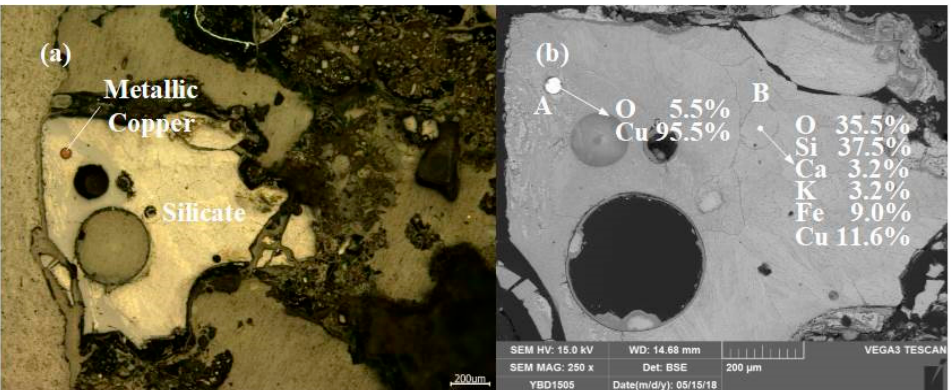
Figure 22. Optical micrograph ( a ) and SEM backsca tt ered electron image ( b ) of YBD16. Sample YBD17: Under the metallographic microscope, copper particles could be de- tected. EDS characterization showed that the copper particles contain 1.8% O, and Cu 2 O solid (cuprite) solution exists in the copper particles. Fe 3 O 4 (magnetite) was fi lled between 2FeO·SiO 2 (fayalite) grains. As shown in Figure 23.